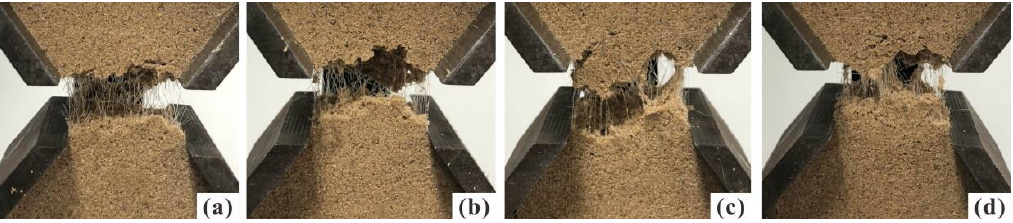
Figure 10. Photographs of specimen with different PU content after test: ( a ) p = 1%; ( b ) p = 2%; ( c ) p = 3%; and ( d ) p = 4% ( f = 0.4%, 𝜌 𝑑 = 1.50 g/cm 3 and t = 48 h).